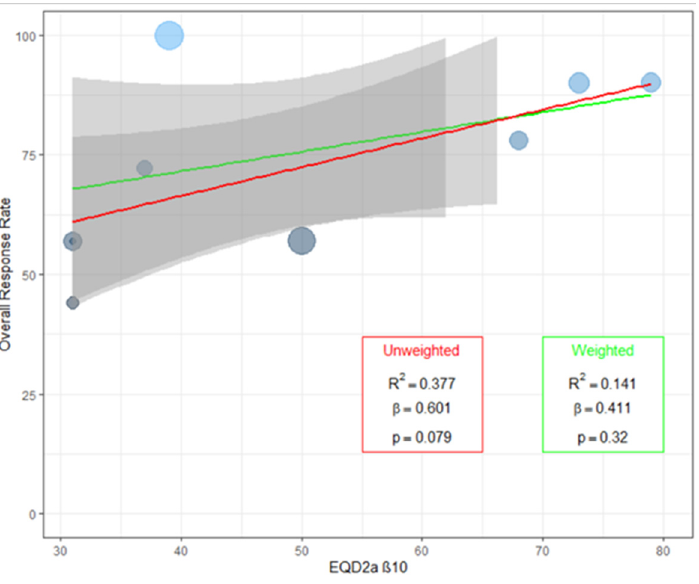
Figure 5. Linear regression: equivalent doses in 2-Gy fractions (EQD2) versus overall response rate of pain.